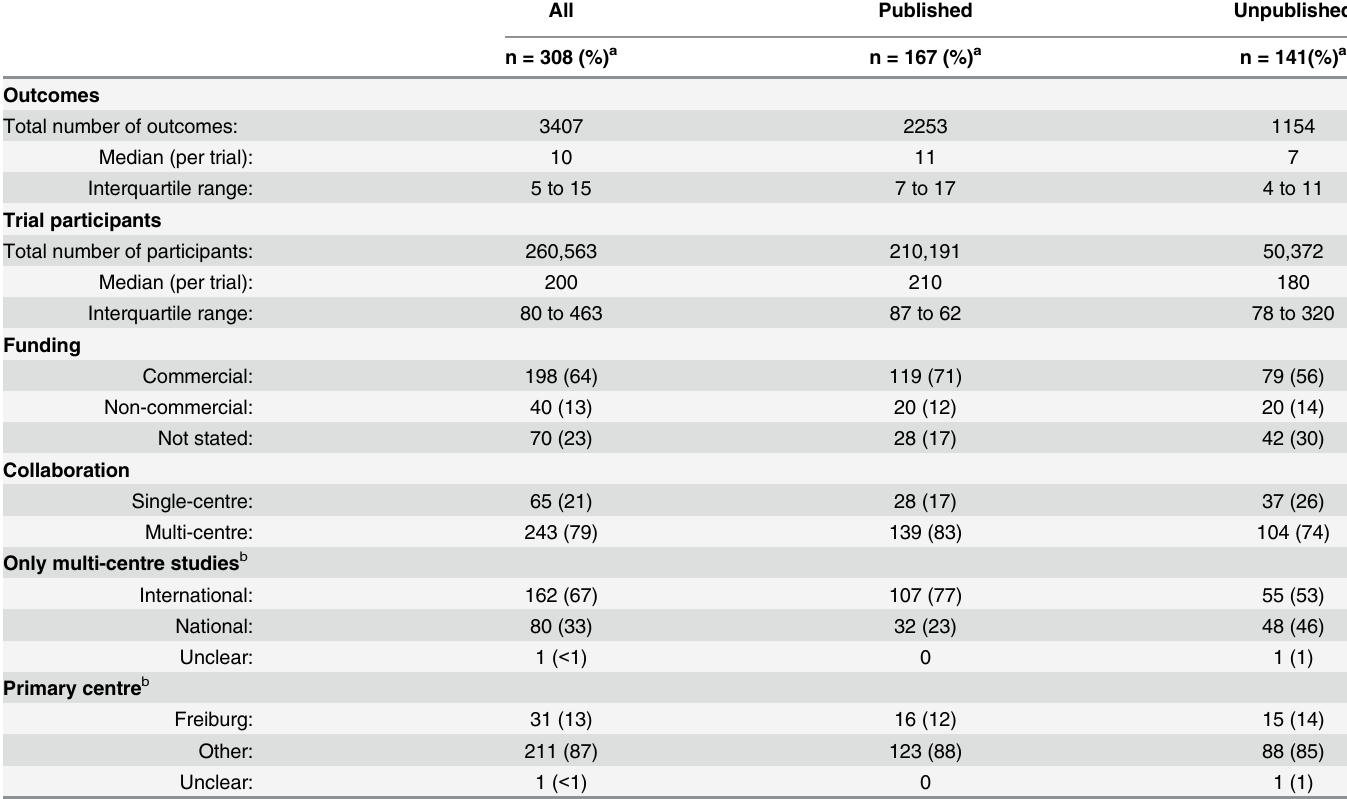
Table 1. Outcome, participant and funding characteristics of trials that were published and unpublished.